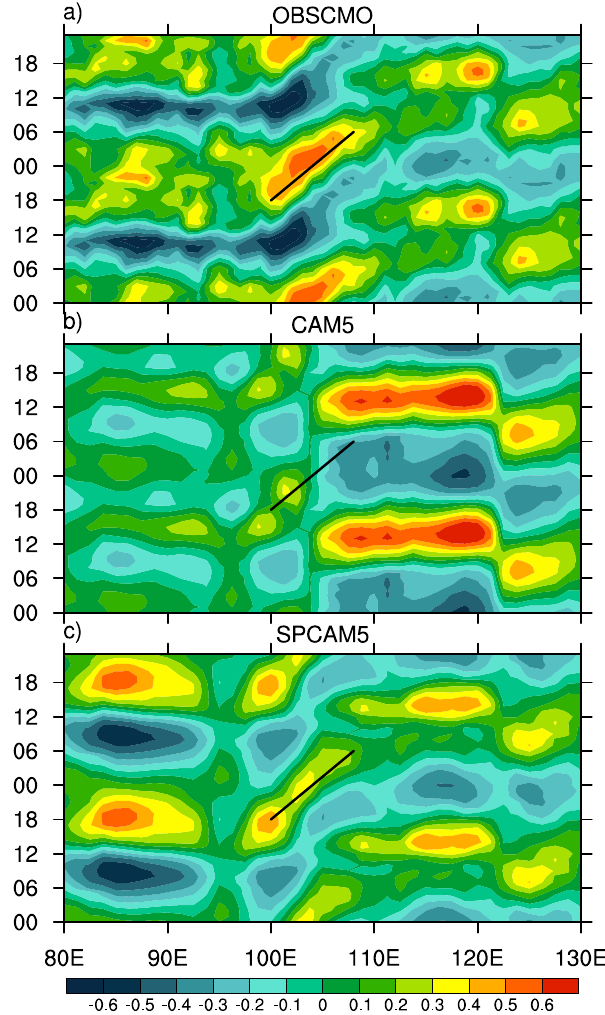
Figure 3. Hovmöller diagrams of the normalized rainfall rates averaged within 27–32° N in, ( a ) OBSCMO, ( b ) CAM5, and ( c ) SPCAM5; the horizontal axis denotes the longitude, and the vertical axis denotes the local solar time.